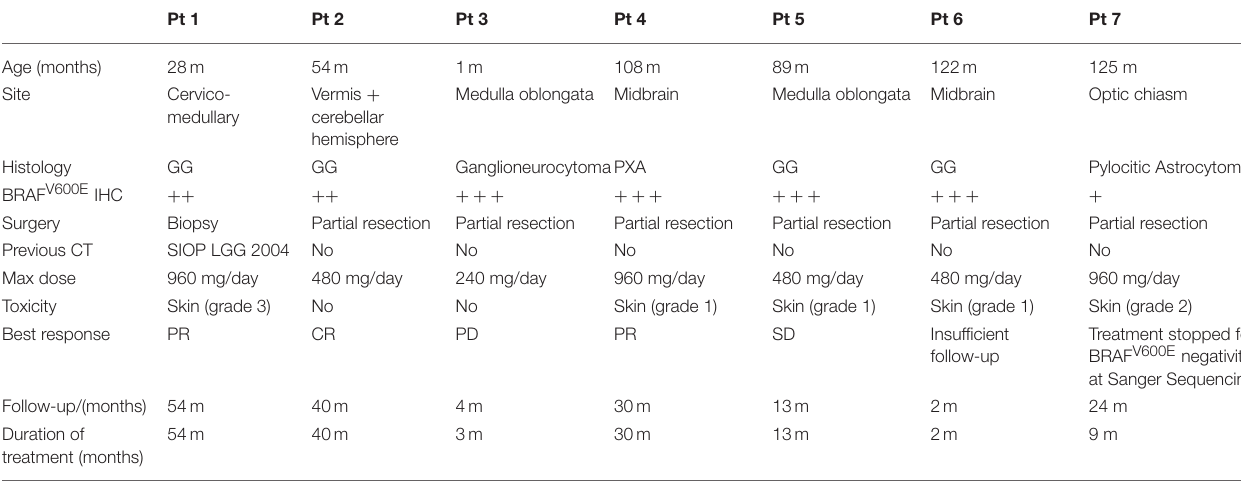
TABLE 1 | Clinical-pathological characteristics of patients and BRAF V600E immunostain